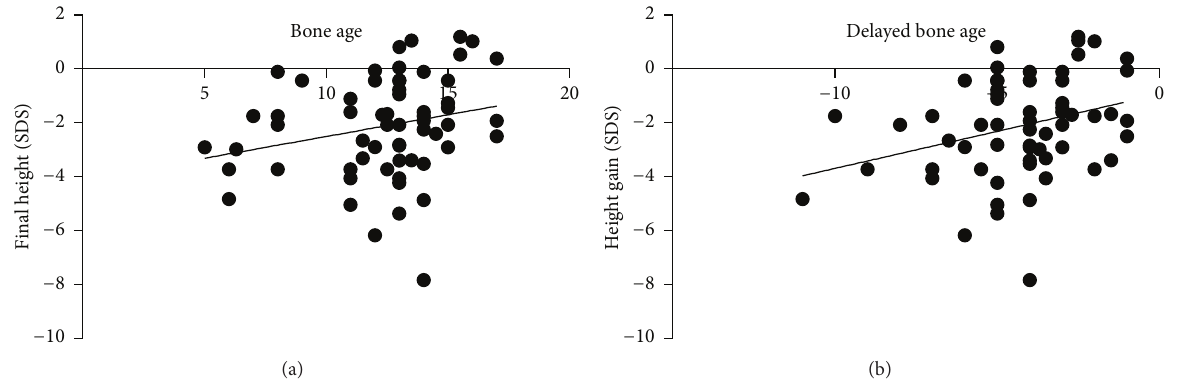
Figure 3: Correlation between bone age/delayed bone age and final height. (a) Correlation between bone age and final height. (b) Correlation between delayed bone age and height gain.